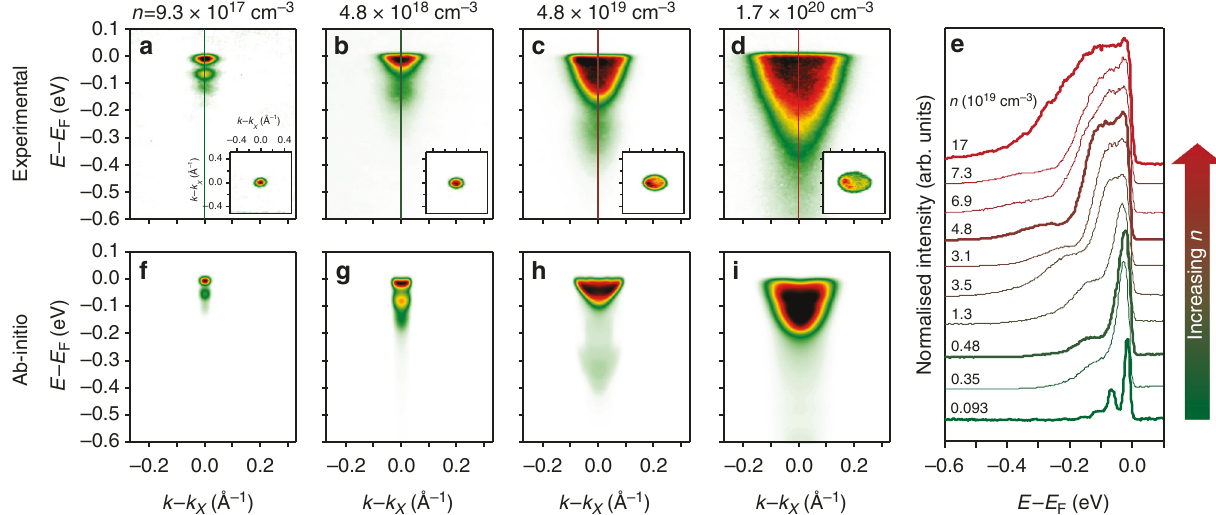
Fig. 2 Spectroscopic observation of lattice polarons in dilutely doped EuO. a Measured and b calculated occupied part of the single-particle spectral function of dilutely doped Eu 1 − x Gd x O ( x = 0.023, n = 9.3×10 17 cm − 3 , see Methods). Replica satellite bands below the main quasiparticle band that crosses the Fermi level are evident. c These are visible up to third order in an EDC taken at k = k X , visible as distinct peaks (green shading) separated from the main quasiparticle peak (orange shading) by integer multiples of the LO phonon energy. d Similar features are evident in our ab initio many- body calculations which explicitly treat electron − phonon coupling from fi rst principles